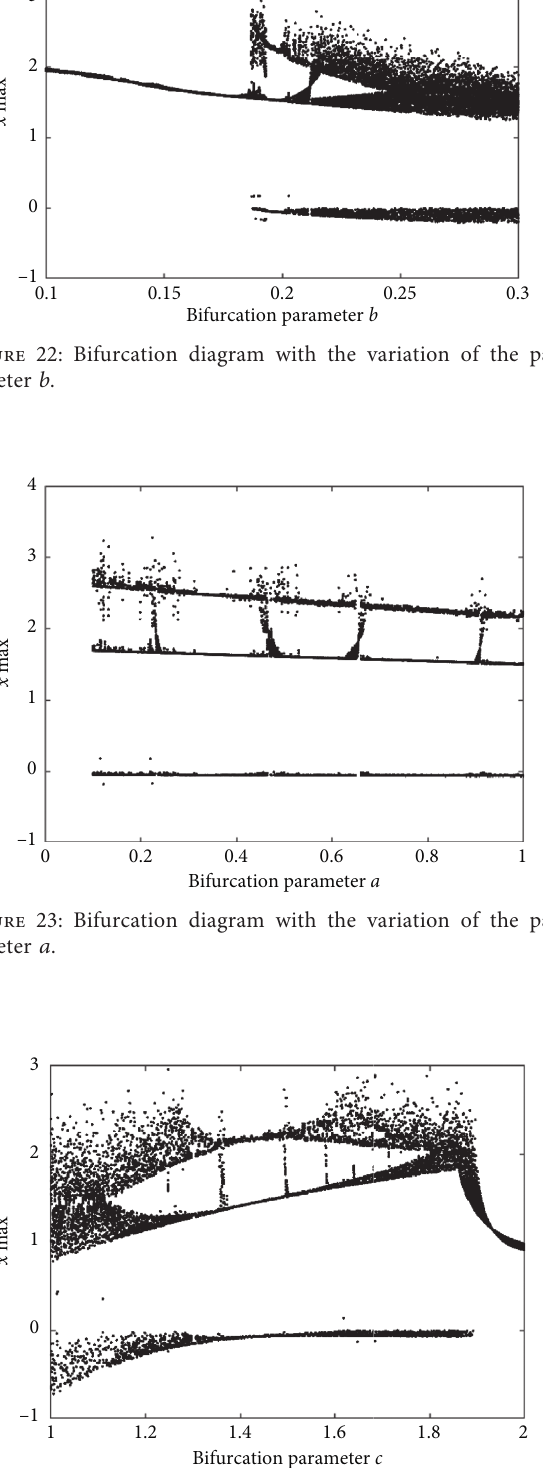
Figure 24: Bifurcation diagram with the variation of the pa- rameter c